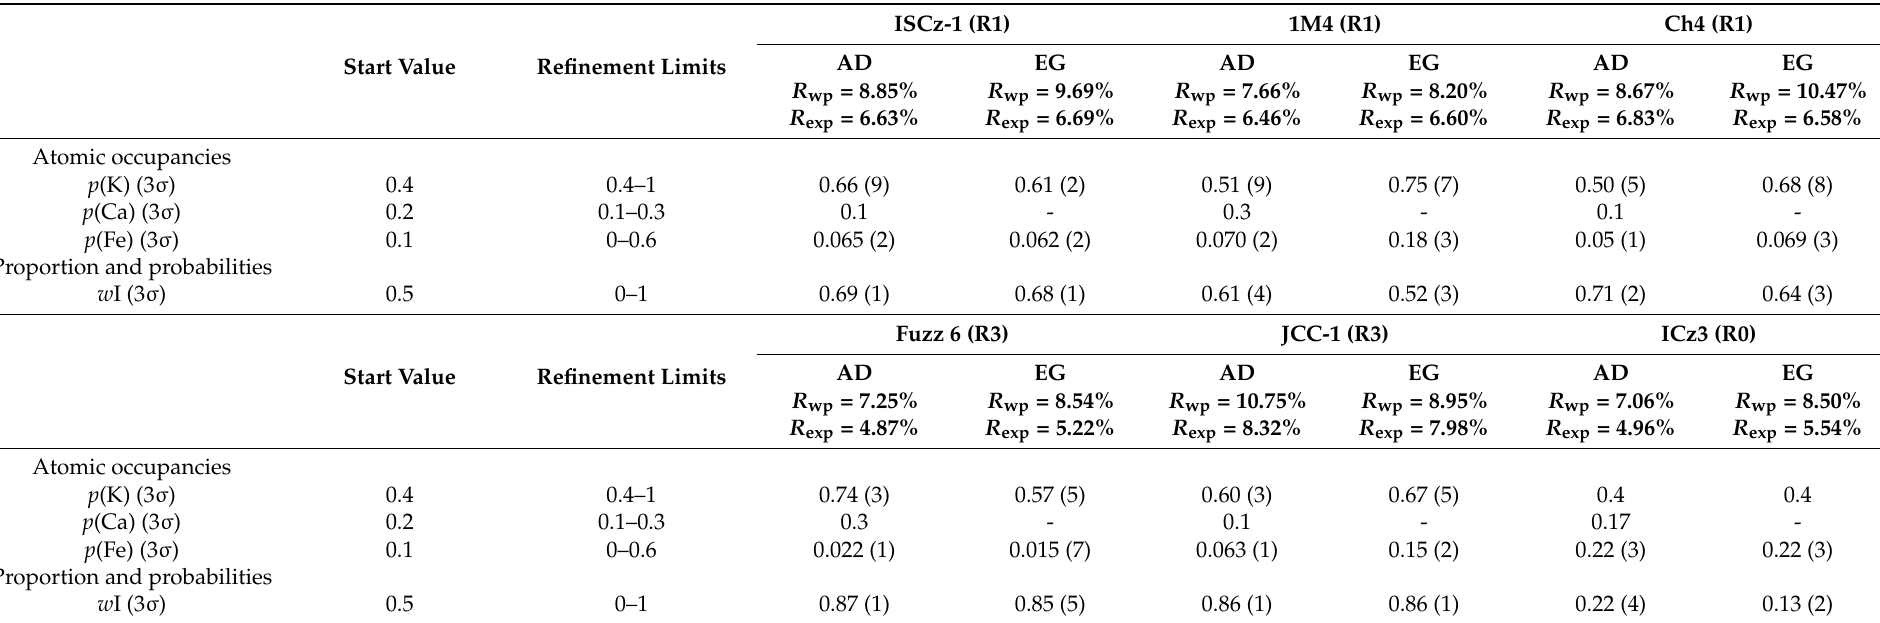
Table 7. Refinement results of oriented samples in AD and EG